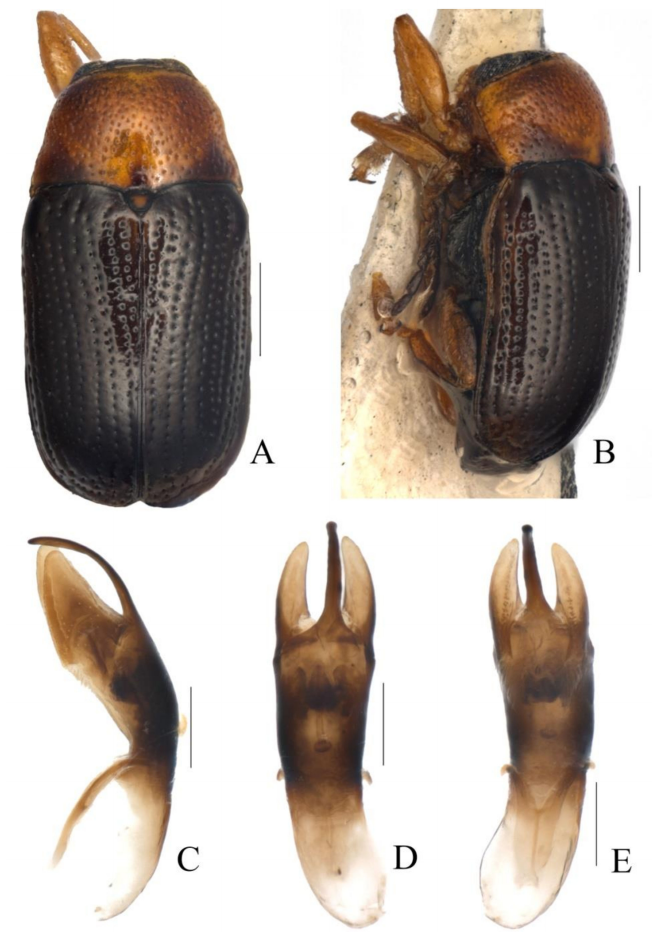
Figure 31. Cryptocephalus ( Burlinius ) scutemaculatus Tan, 1992: ( A ) habitus; ( B ) lateral view of habitus; ( C ) lateral view of aedeagus; ( D ) dorsal view of aedeagus; ( E ) ventral view of aedeagus (Scale bars: ( A , B ) = 0.5 mm, ( C – E ) = 0.2 mm) (holotype, male).